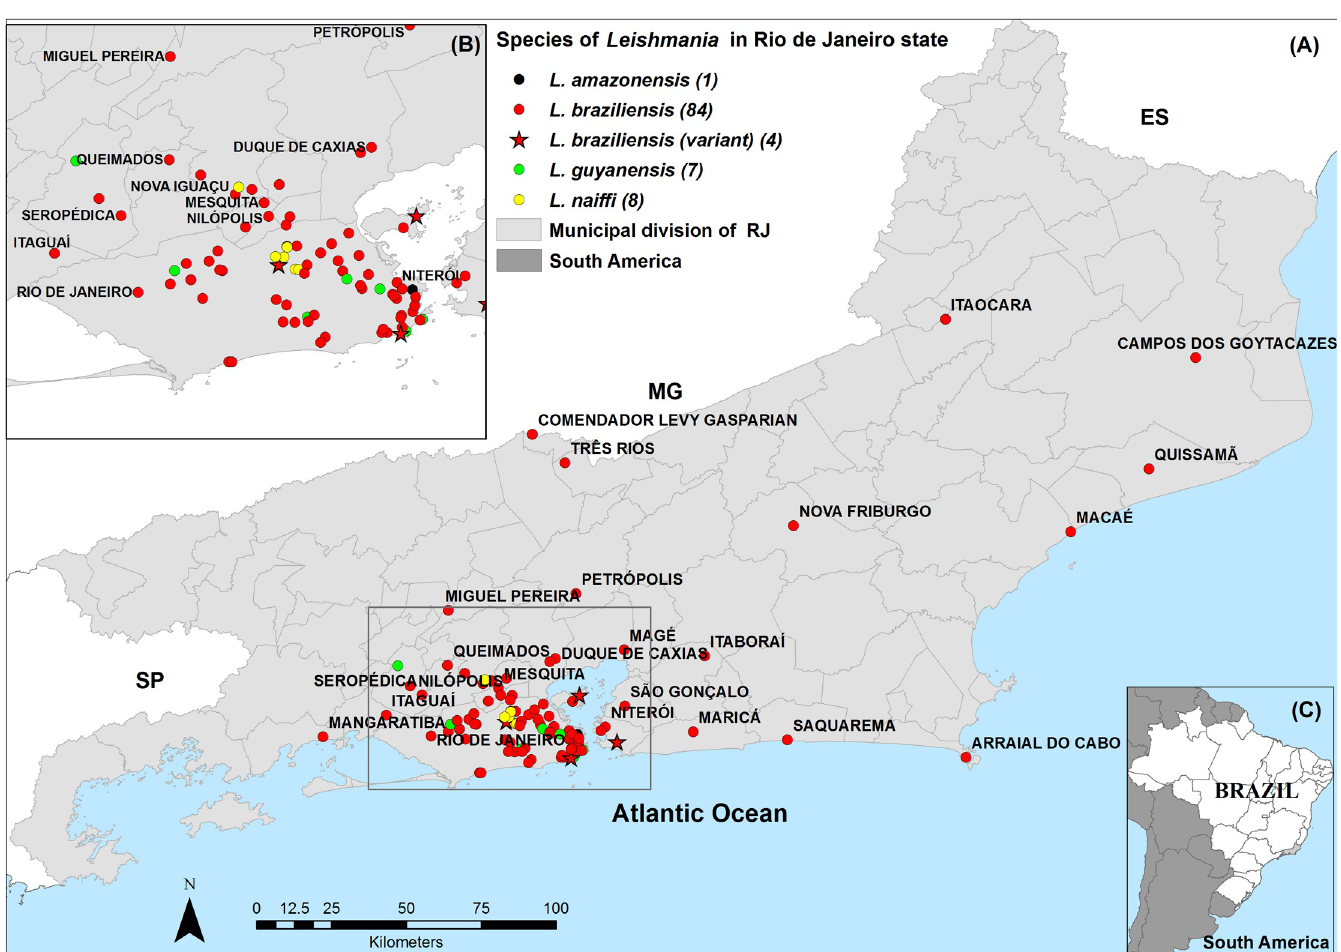
Fig 2. Species of Leishmania in Rio de Janeiro (RJ) state. The 104 typed species of Leishmania were plotted on the map by municipalities of RJ state (A); The municipality of Rio de Janeiro and some neighboring municipalities are highlighted to facilitate the visualization of the identified Leishmania species (B); Location of RJ state on maps of Brazil and South America (C). SP = S ã o Paulo state; MG = Minas Gerais state; ES = Espı´rito Santo state. This map was created using ArcGIS 9.1 software and cartographic bases obtained from the Brazilian Institute of Geography and Statistics (https://ibge.gov.br/).